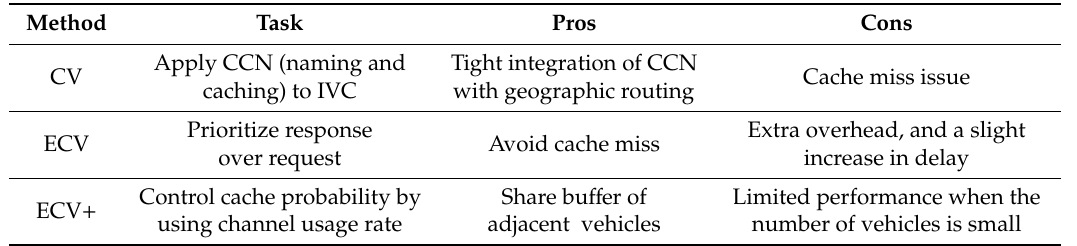
Table 3. Comparison of three methods.